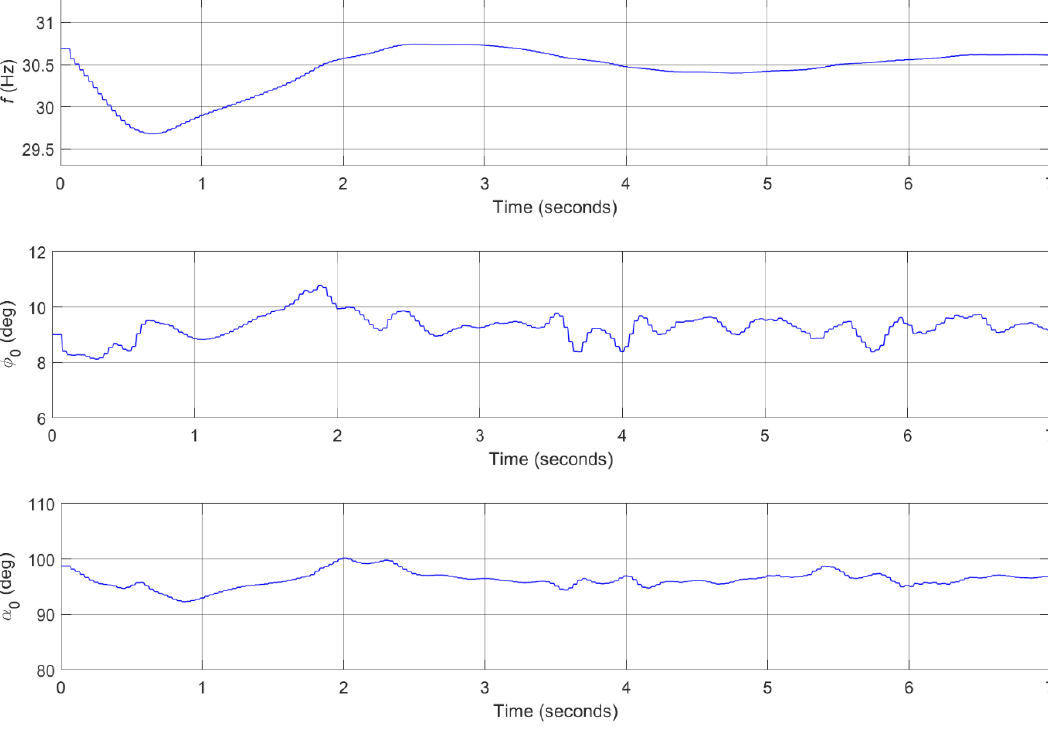
Figure 28. Flight control inputs for trajectories tracking control of nonlinear FWMAV model (case 3).